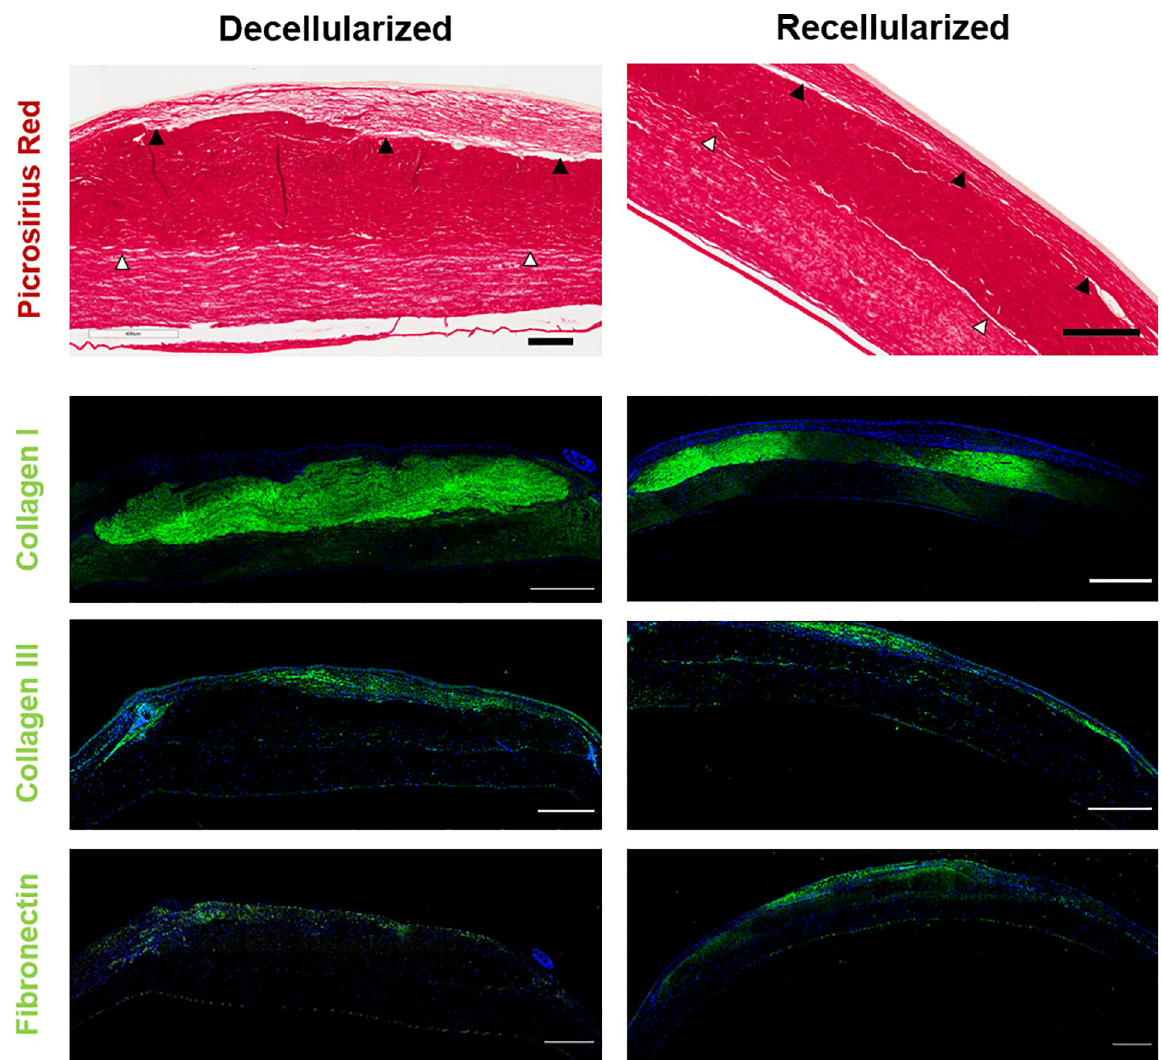
Fig 11. Rabbit cornea 3 months post-implantation stained for cell distribution and phenotype. Representative images of decellularized (left) and recellularized implant (right). A) H&E staining (Scale bar = 1 mm, 200 μ m, low and high magnifications). Scaffold apposed with native tissue (white arrows) and regeneration area anterior to the scaffold (black arrows). B) Immunostaining for ALDH1A1 and, C) for α -SMA. B) and C) larger image is whole cornea with close-ups of anterior regenerating layer, central scaffold and posterior native cornea. (Scale bar = 500 μ m, 50 μ m, low and high